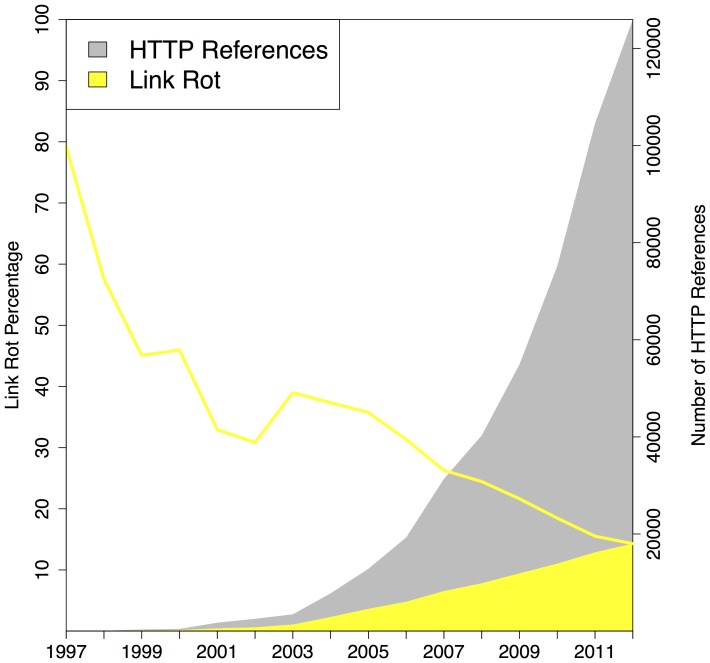
Link Rot - PMC corpus.